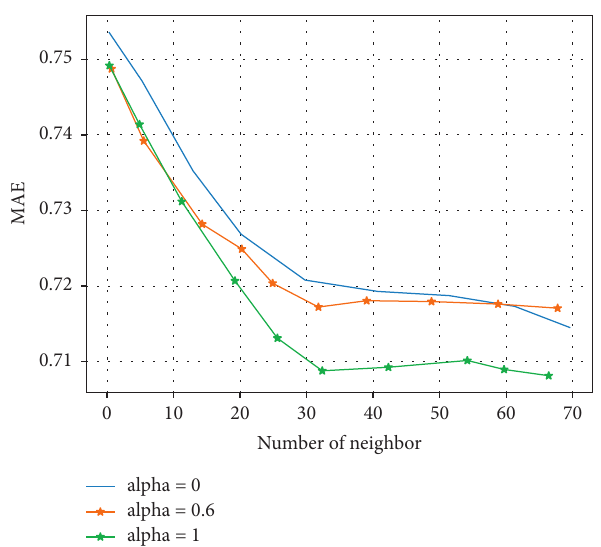
Figure 6: Effect of number of